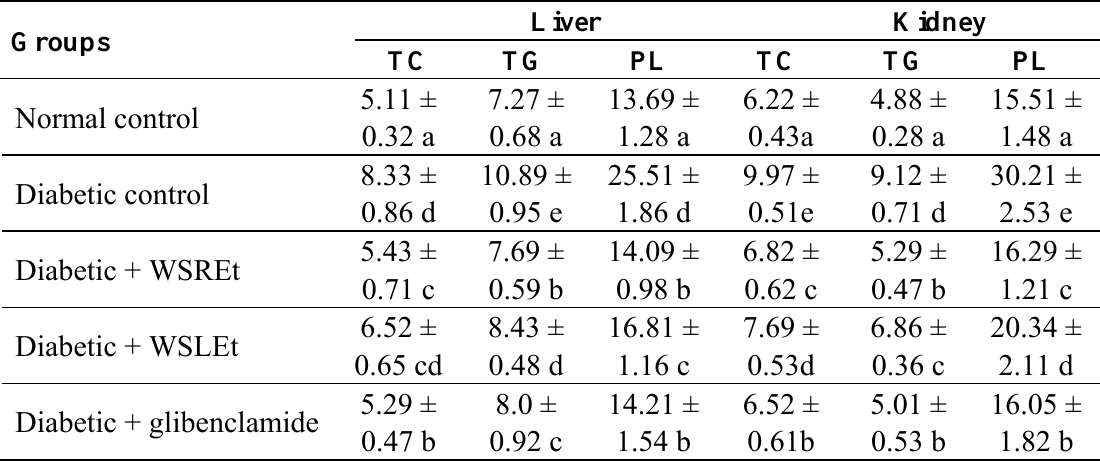
Table 5. Effects of W. somnifera (L.) extracts on liver and kidney lipids.